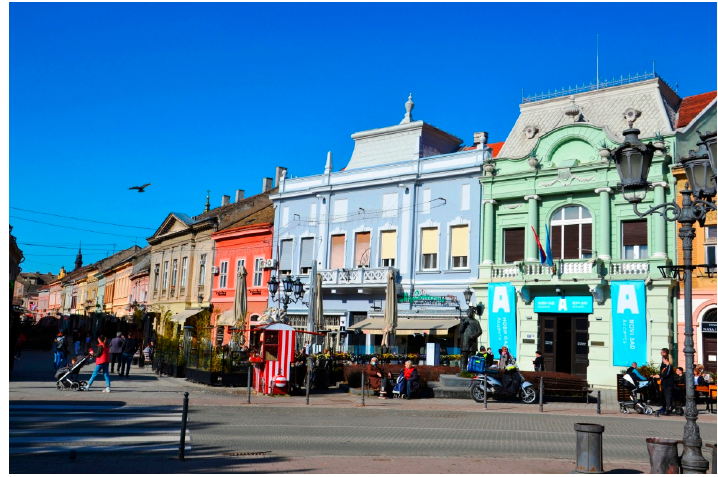
Figure 1. Colors of ethnic groups on the facades of one of the oldest streets in the city. Source: Bojan Đ er č an, February 2022.